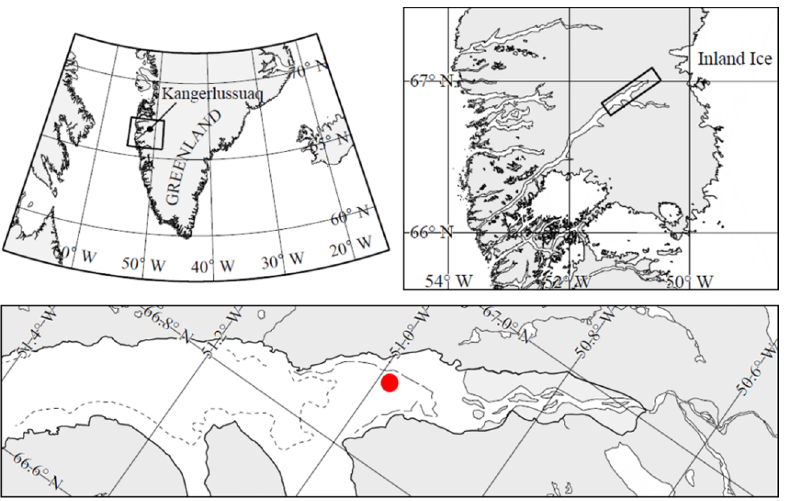
Figure 1. Map showing location of Kangerlussuaq study area in south-west Greenland and location of the sea ice station used in the study (map adopted from Nielsen et al. 2010).